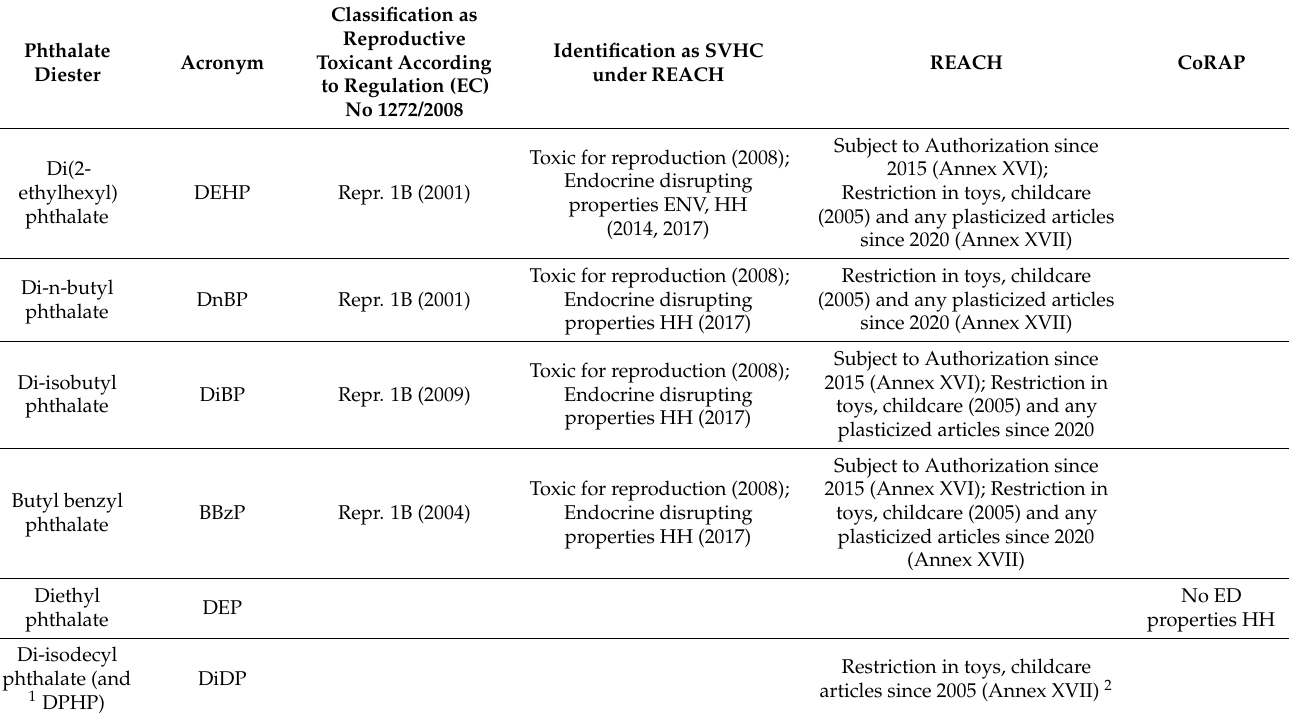
Table A1. Overview of measured exposure biomarkers of 12 phthalate parent